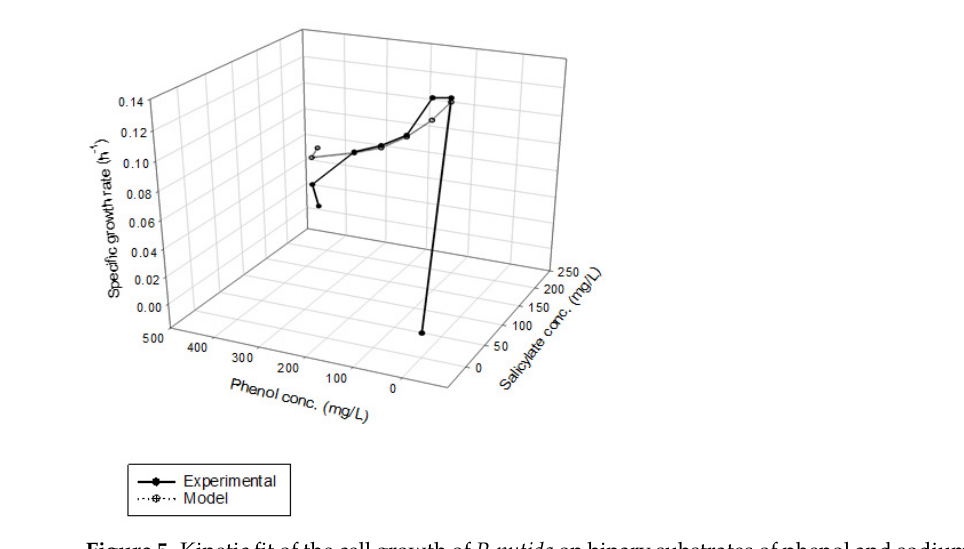
Figure 4. Variation of binary substrates with time: ( a ) phenol biodegradation, ( b ) salicylate biodeg- radation, and ( c ) cell growth.